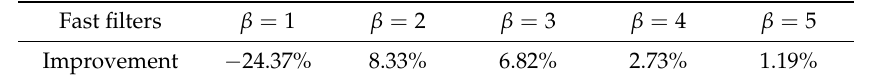
Table 2. Total optimal sub-pattern assignment (OSPA) distance improvement of different fast filters.